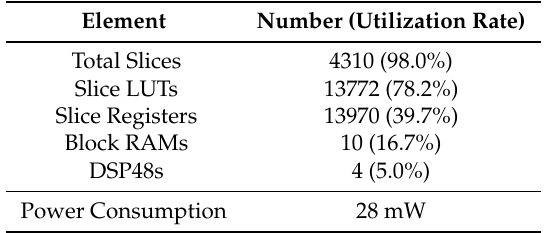
Table 1. Synthesis details of designed ADPLL (Tool: Xilinx Vivado